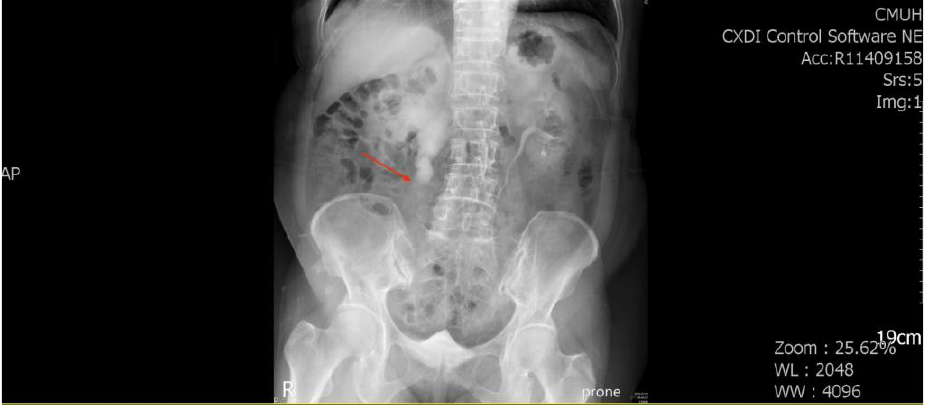
Figure 1. Intravenous pyelography revealed an obstruction at the right upper ureter (arrowhead). She underwent ureterorenoscopic surgery under the impression of a ureteral stone with obstruction. During the operation, a small stone was found with a tumor-like lesion below the stone. An endoscopic biopsy was performed during the operation, and the pathology report was chondrosarcoma. The tumor was heterologous and composed of epithelioid cell and chondrosarcoma components. The tumor’s immunoprofile was CK (+, only in the epithelioid tumor cells), vimentin (+, in both the epithelioid cells and chondrosarcoma cells), S100 (+, only in the chondrosarcoma cells), and GATA3 ( − ) (Figure 2). The picture was compatible with carcinosarcoma. Computed tomography (CT) of the abdomen revealed a tumor mass obstructing the upper ureter with proximal dilatation (Figure